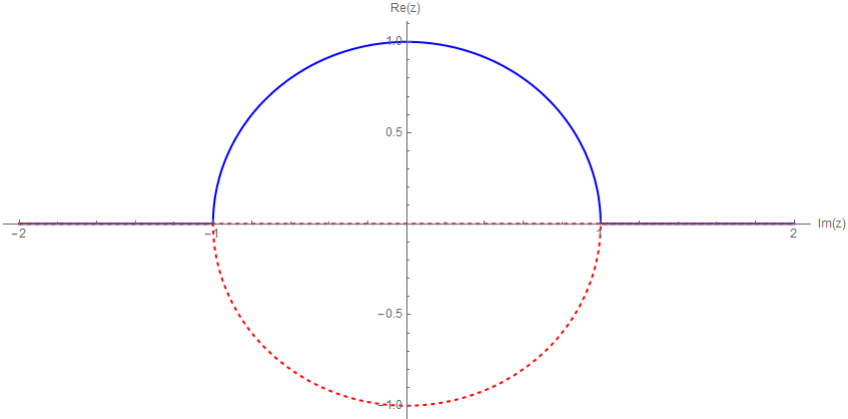
Figure 3. The restriction of the unit circle monodromy matrix to SU(1 ; 1) restricts the eigenval- ues it can possess to be either purely real or pure phases. Since the eigenvalues are each others inverse (cid:21) 1 = 1 =(cid:21) 2 , the domain in which the eigenvalues can reside can be further split up into two independent domains indicated by the blue solid line and red dashed